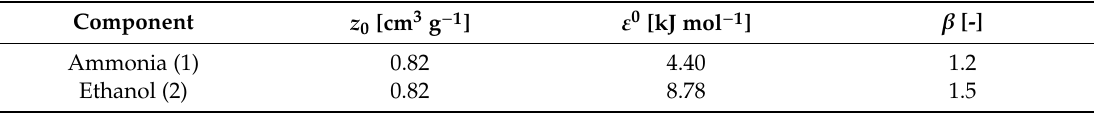
Table 5. Parameters of the Dubinin–Astakhov Model for Ammonia and Ethanol on SRD 1352 / 3. Equilibrium Data are from